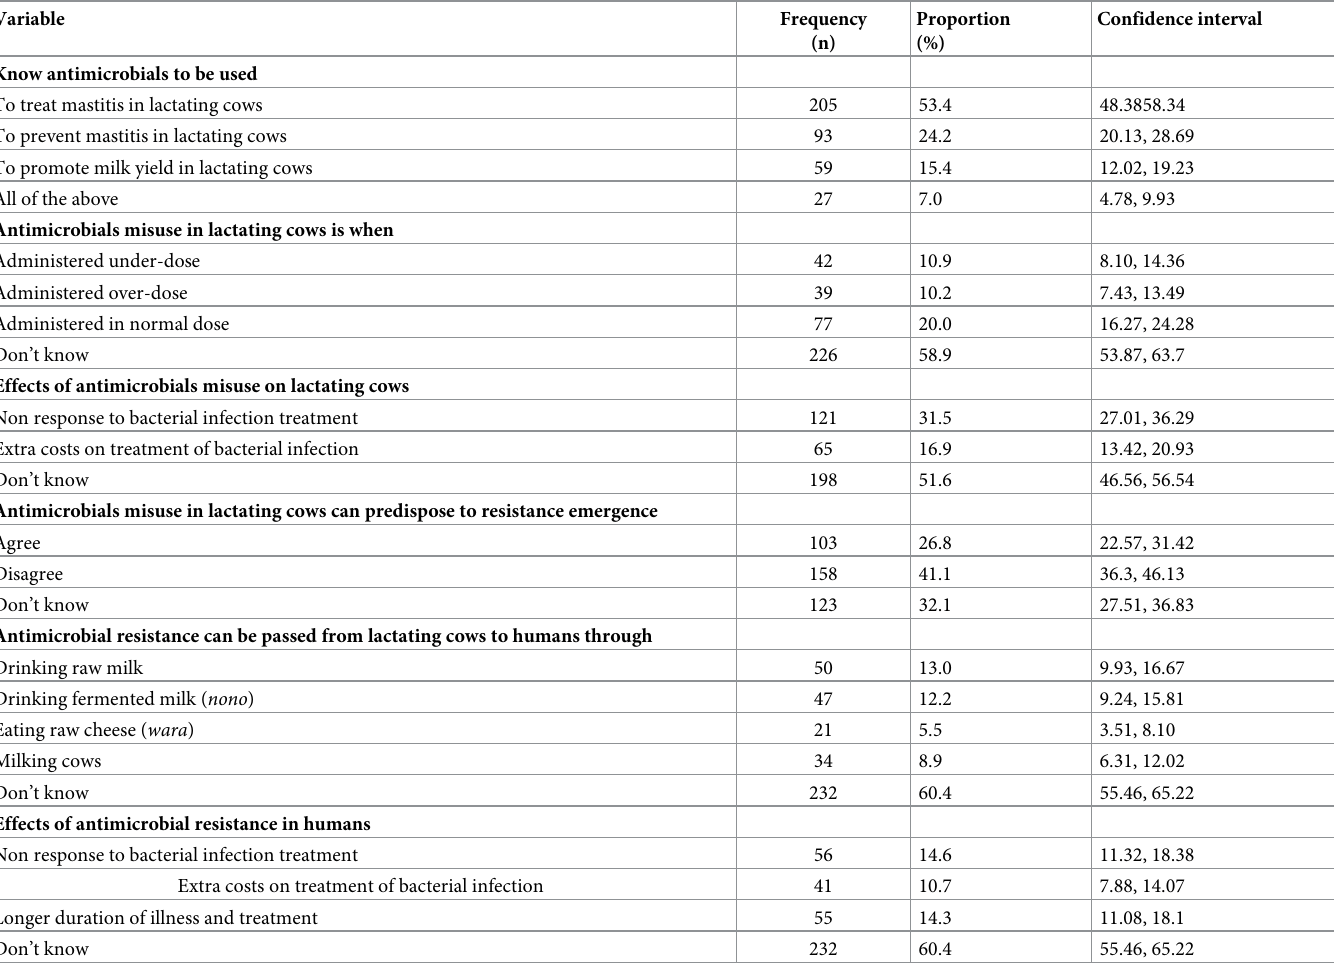
Proportion Confidence interval (n) (%)